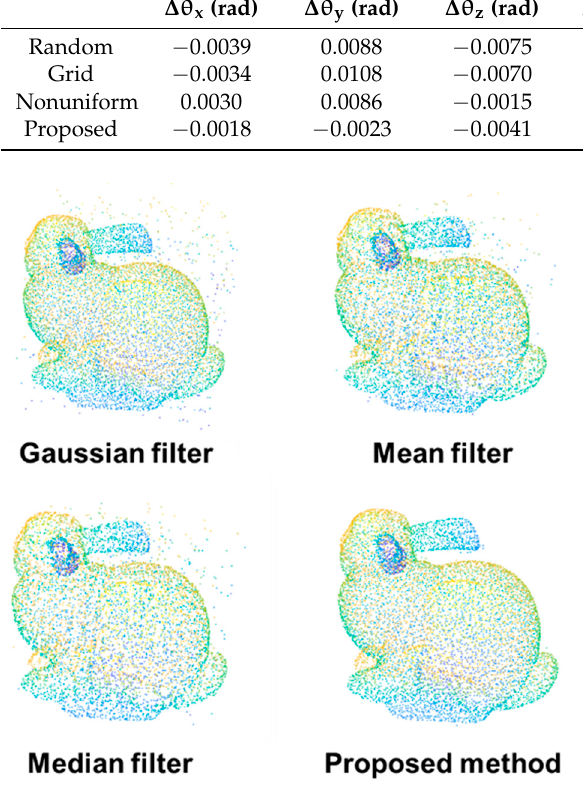
Figure 5. Comparison of point cloud denoising